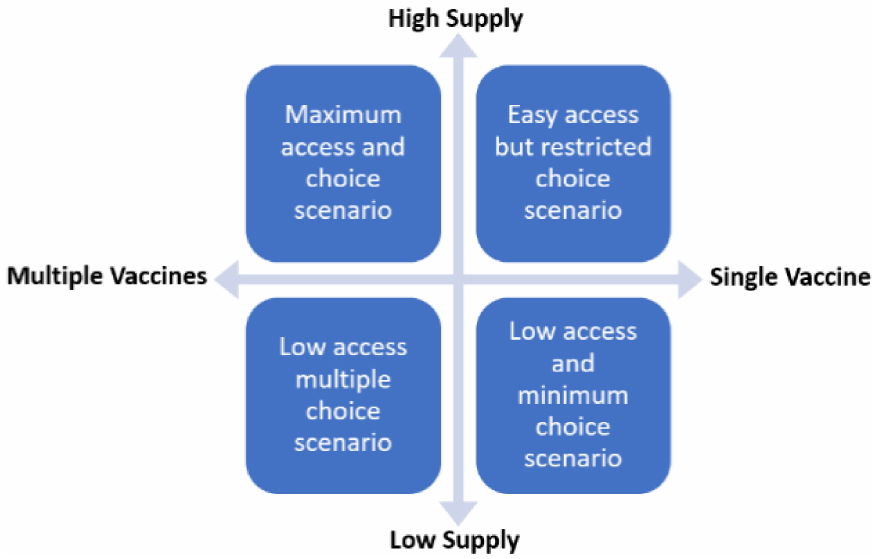
Figure 2. Vaccine Choice